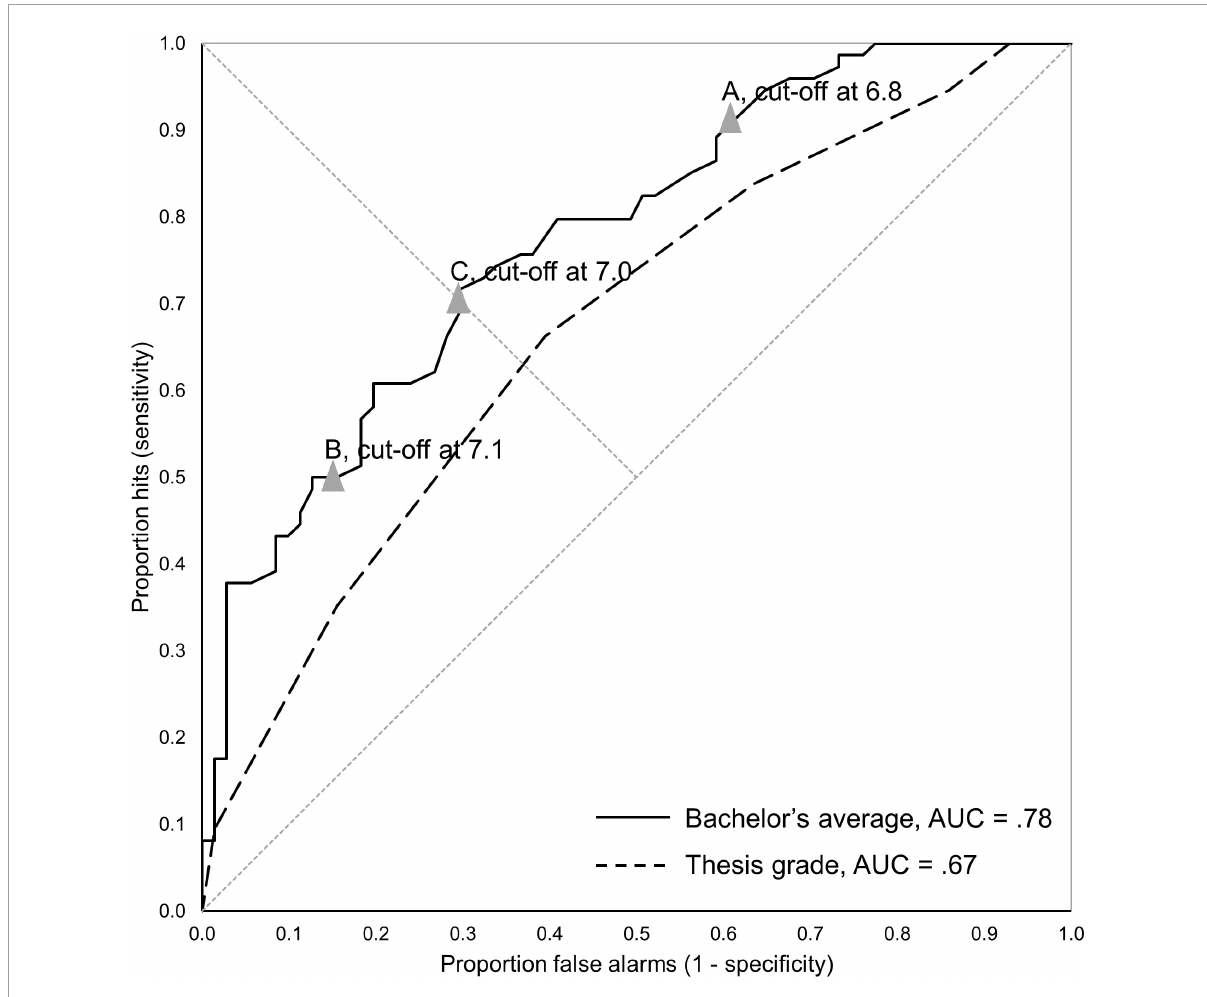
FIGURE2 ROC-curves of demonstration data. ROC-curves of average bachelor grade and thesis grade with average master grade ≥ 7.7 as the definition of student success. Data points A, B, and C are the ones that correspond closest to the intended selection outcome as specified in Table 2 . See also Figure 3 and Table 3